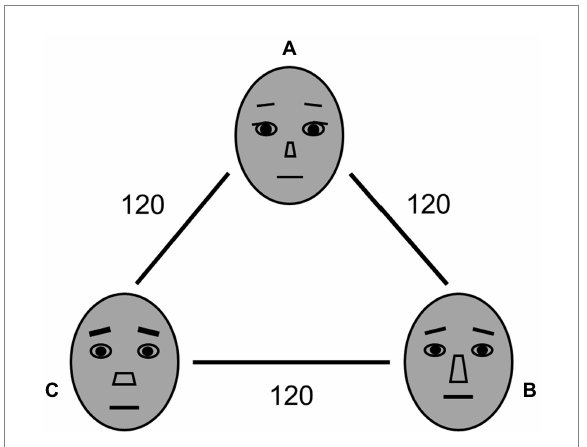
FIGURE 1 Three neutral female faces (A–C) from the NimStim Set of Facial Expressions used to produce 360 face morphs in each color for Experiments 1 and 2, and represented with schematics in